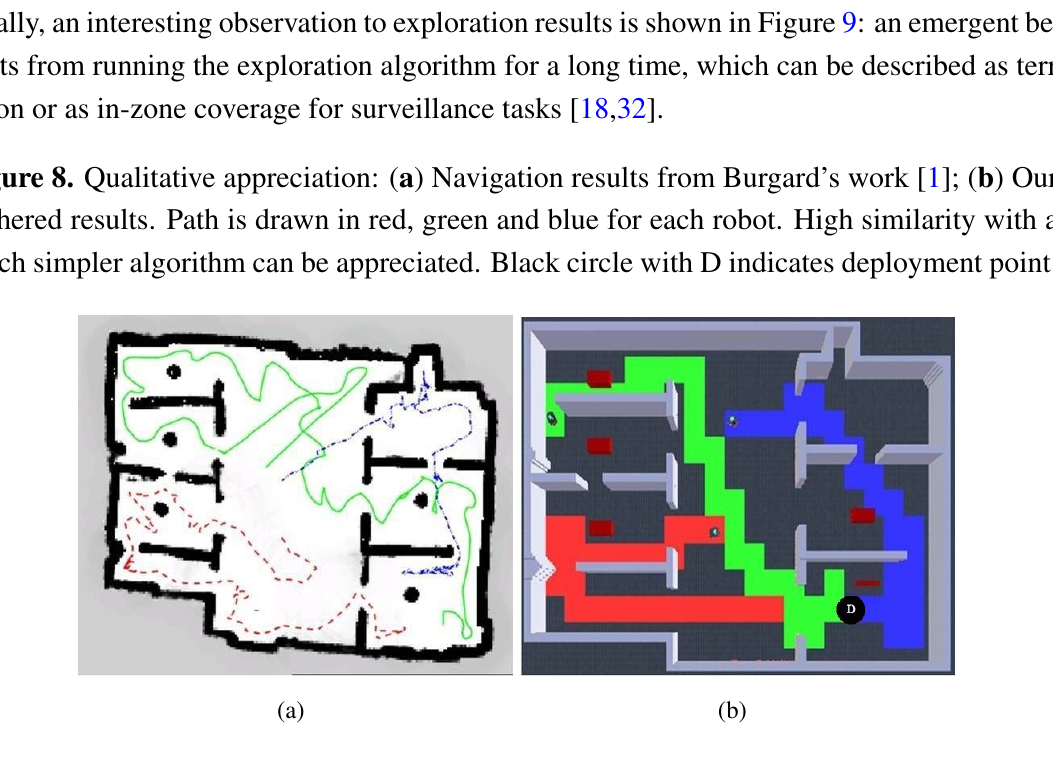
Figure 9. The emergent in-zone coverage behavior for long time running the exploration algorithm. Each color (red, green and blue) shows an area explored by a different robot. Black circle with D indicates deployment